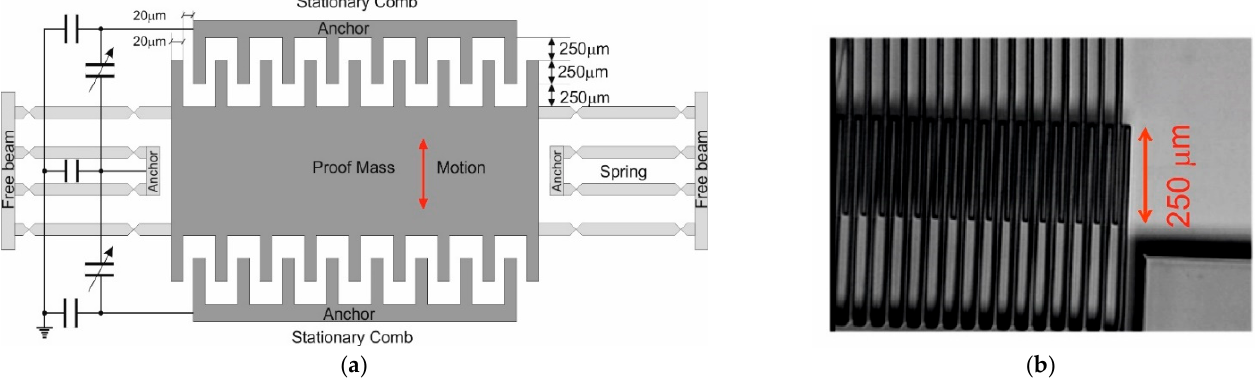
Figure 9. Electrostatic generator built according to MST technology, operating in a constant voltage system; ( a ) generator diagram; ( b ) actual view of the comb capacitor.